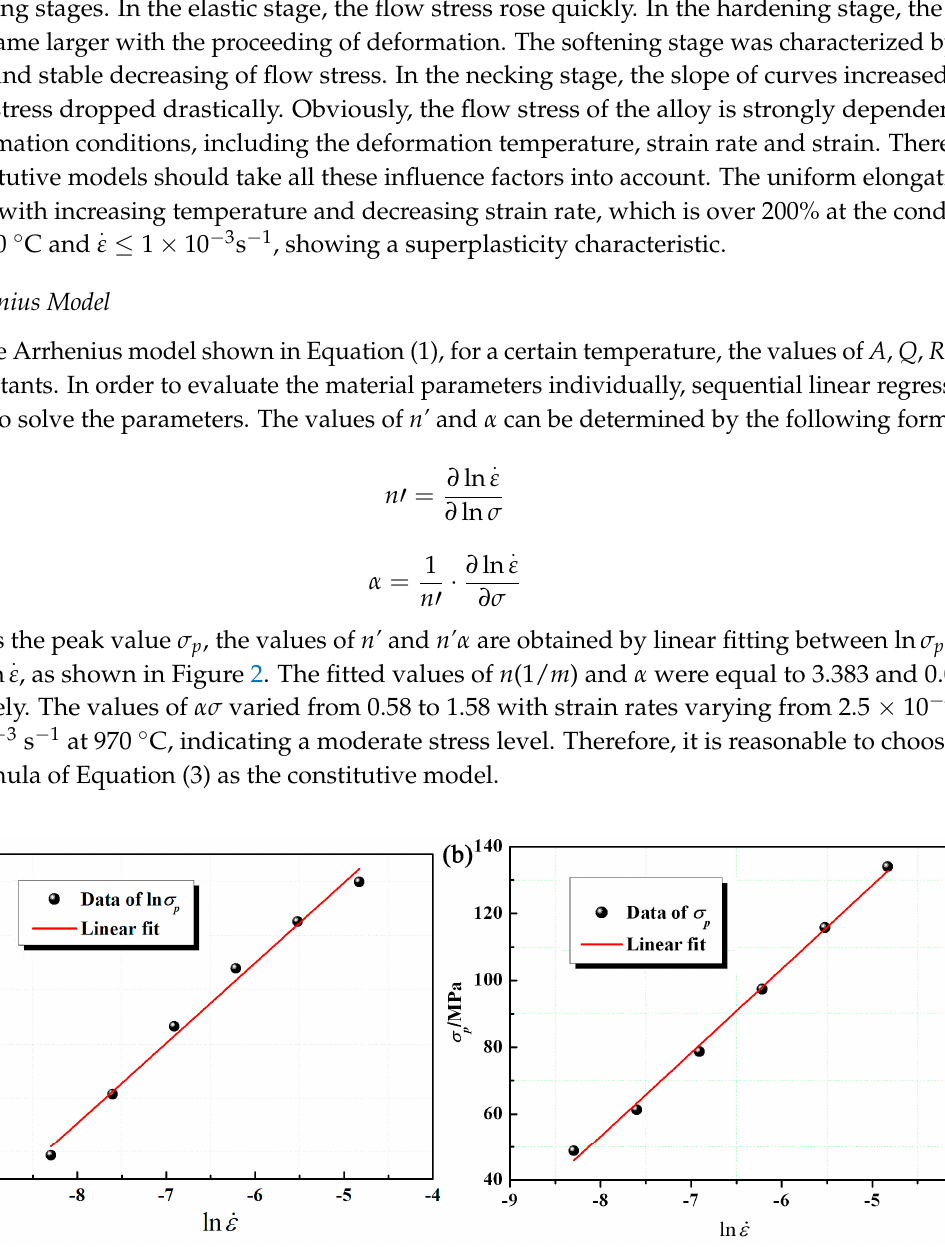
. σ ε vs ln ε  . Figure 2. Relationship of: ( a ) ln σ p vs. ln p